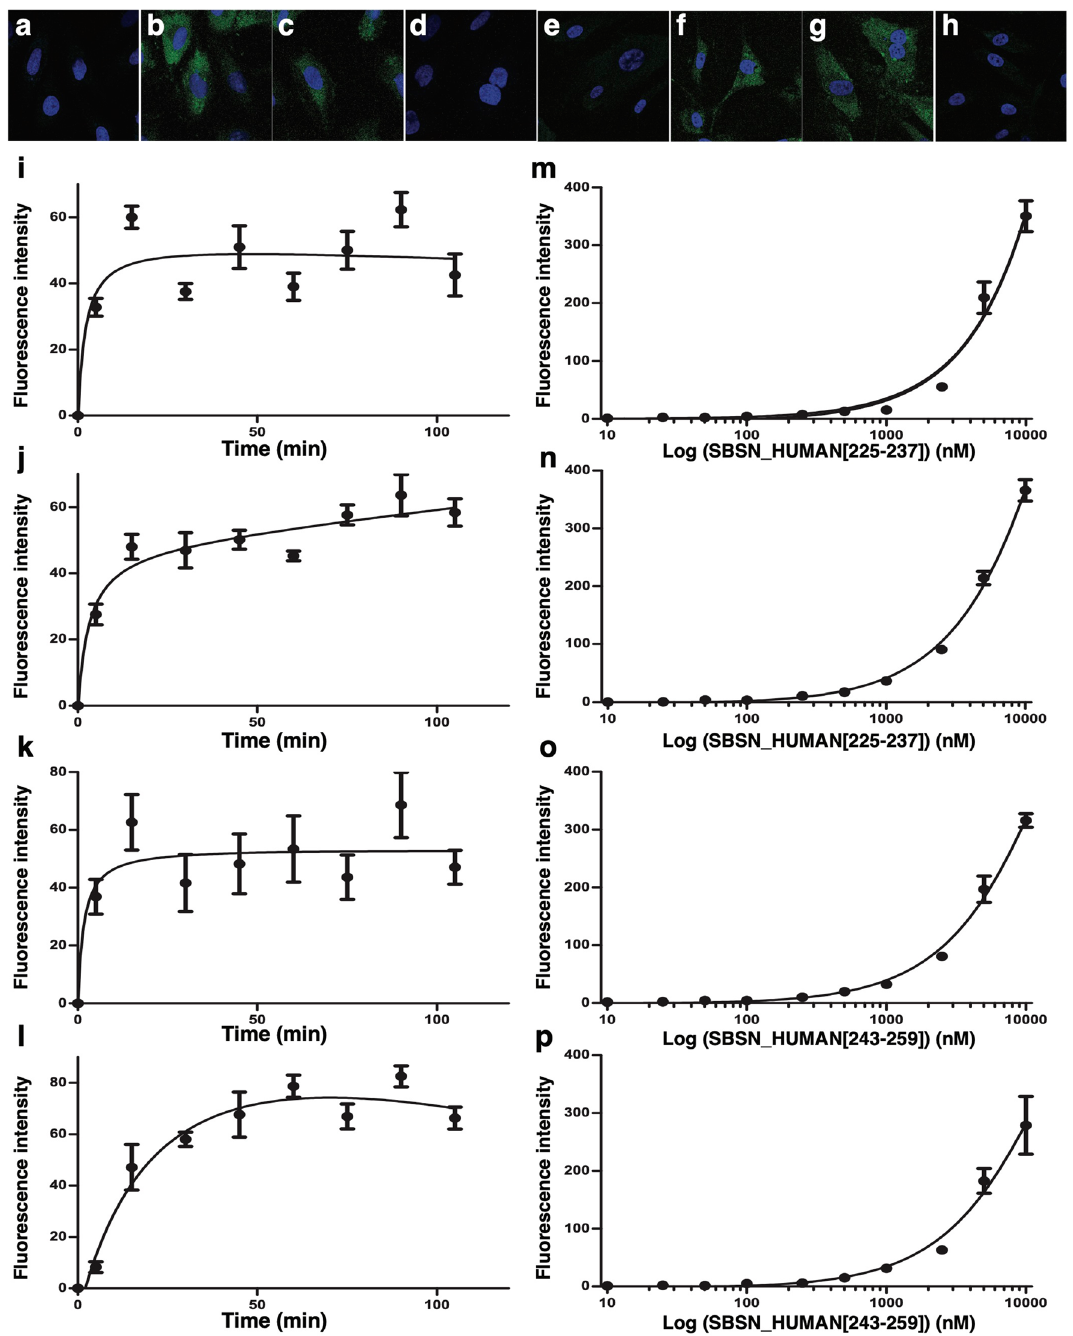
Figure 4. Binding of suprabasin-derived peptides to HAoSMCs. ( a – h ) Confocal laser-scanning microscopy images of fluorescent suprabasin-derived peptides bound to cultured A10 cells and HAoSMCs. Growing A10 cells ( a – d ) and HAoSMCs ( e – h ) were deprived of serum for 16 h and overlayed without ( a , e ) or with 10 –6 M FAM-SBSN_HUMAN[225–237] ( b , f ), FAM-SBSN_HUMAN[243–259] ( c , g ), or FAM-SBSN_HUMAN[279– 295] ( d , h ) for 30 min. Cells were washed, fixed, the nuclei counterstained with DAPI (blue) and the cell surface-bound green fluorescence visualized. ( i – l ) Time course of FAM-SBSN_HUMAN[225–237] and FAM-SBSN_HUMAN[243–259] bound to the cell surface. FAM-SBSN_HUMAN[225–237] ( i , j ) or FAM- SBSN_HUMAN[243–259] (10 –6 M) ( k , l ) was overlayed on confluent cultures of A10 cells ( i , k ) or HAoSMCs ( j , l ) in 96-well plates for the indicated times and, after extensive washing, cell-bound immunofluorescence was quantified. ( m – p ) Concentration response relationships for FAM-SBSN_HUMAN[225–237] and FAM- SBSN_HUMAN[243–259] bound to the cell surface. Confluent cultures of A10 cells ( m , o ) or HAoSMCs ( n , p ) were treated with the indicated concentrations of FAM-SBSN_HUMAN[225–237] (m , n ) or FAM-SBSN_ HUMAN[243–259] ( o , p ) for 60 min and cell-bound immunofluorescence was